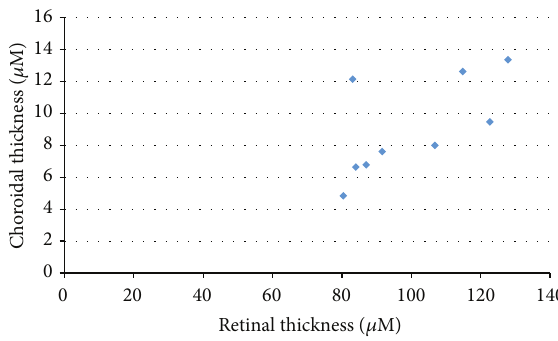
Figure 5: The relationship between the retinal and choroidal thicknesses in the normal SD rats. 𝑟 𝑠 = 0.72 , 𝑃 < 0.05